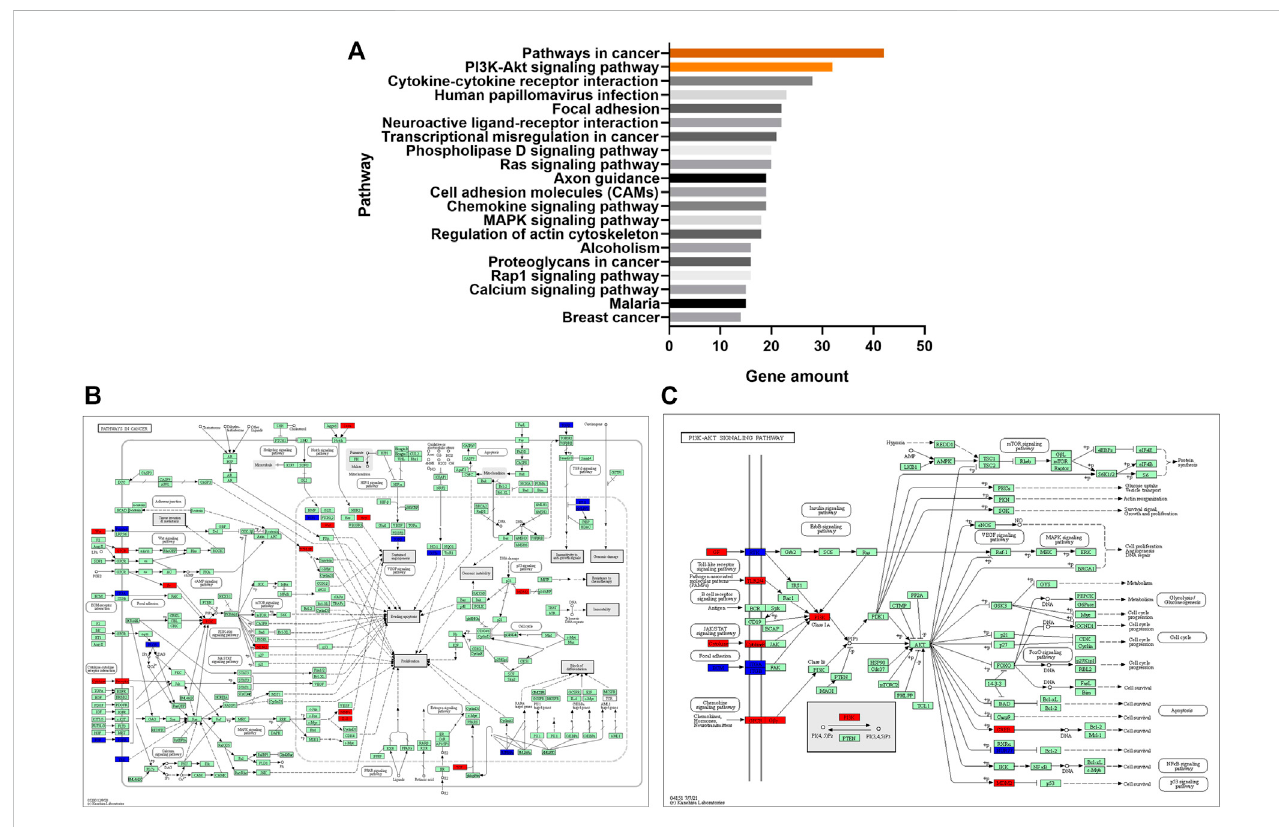
FIGURE 5 (A) , the top 20 signi fi cant signaling pathways were hierarchically clustered into a tree, which showed that the pathways with the most signi fi cant differences were mainly concentrated in pathways in cancer and PI3K-Akt signaling pathway. (B) , the regulatory changes of related mRNAs involved in the pathways of cancer. Red represented upregulation and blue represented downregulation. (C) , the regulatory changes of related mRNAs involved in PI3K-Akt signaling pathway. Red represented upregulation and blue represented downregulation.